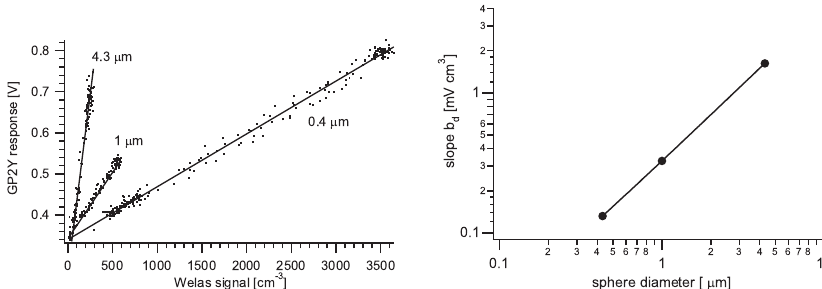
Figure 8. ( Left ) sensor output correlated with particle number concentration for different PSL particle sizes (the same data as in Figure 7). ( Right ) slope dependence on particle size shows best power fit a ( d / d 0 ) n with power n = 1.11 ± 0.04 and a = ( 0.321 ± 0.017 ) mV cm 3 , d 0 = 1 µ m. Numerical results are in Table 2. The data from the Sharp sensor were averaged on the same time scale as the Welas instrument (i.e., 50 s, N =